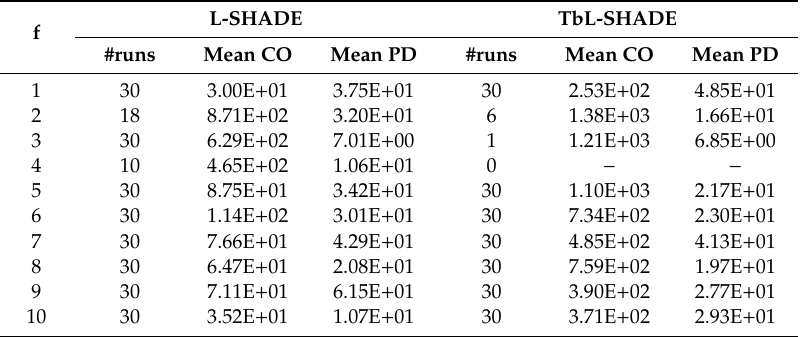
Table 27. Clustering and population diversity of L-SHADE and TbL-SHADE on the CEC2020 in 5 D .